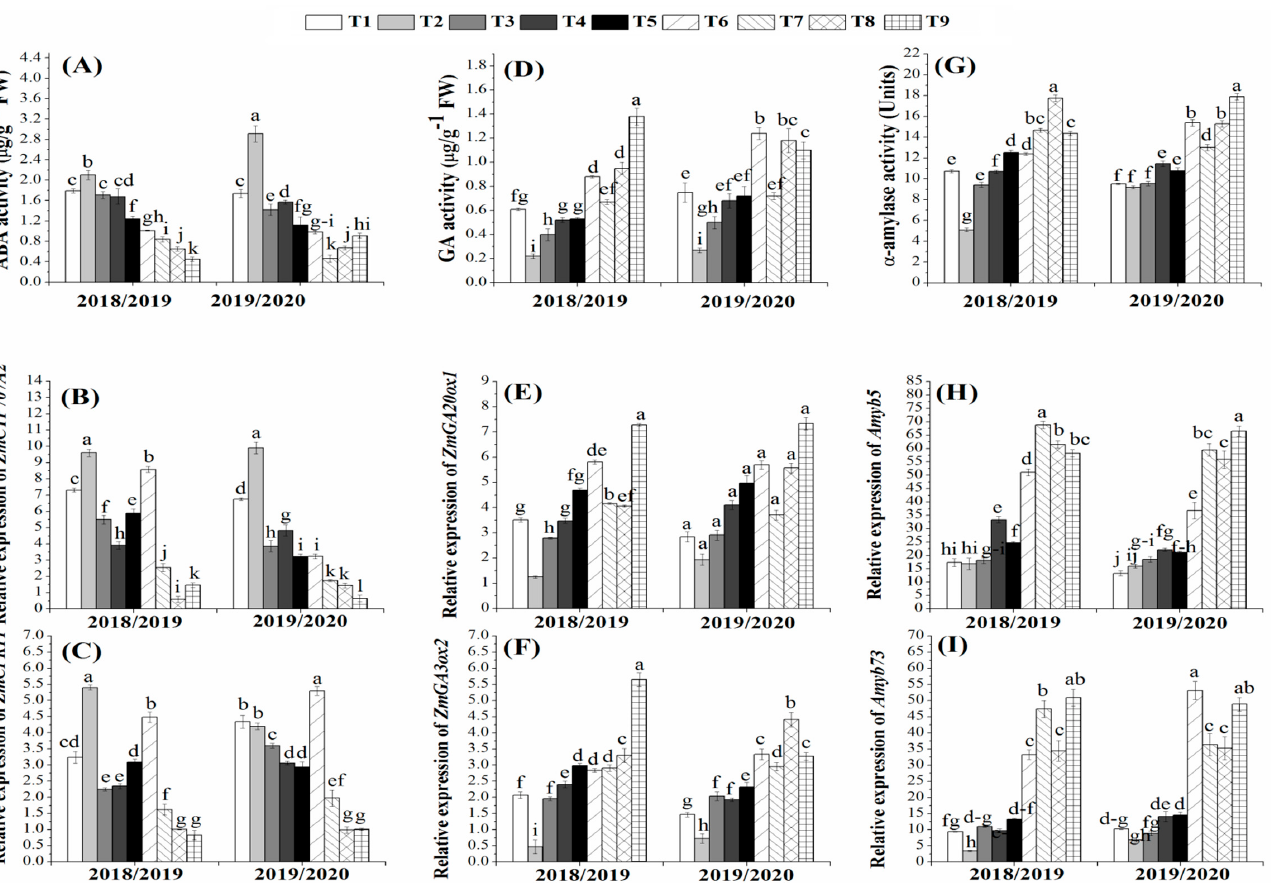
Figure 3. E ff ects of organic and biofertilizers alone or in combination on ABA activity ( A ) and its transcription levels ( B , C ); GA activity ( D ) and its transcription levels ( E , F ); α -amylase activity ( G ) and its transcription levels ( H , I ) in maize grains. (T1 = 100% NPK, T2 = 50% NPK, T3 = Biogas slurry + 50% NPK, T4 = Humic acid + 50% NPK, T5 = Biogas slurry + Humic acid + 50% NPK, T6 = Biofertilizer mixture + 50% NPK, T7 = Biogas slurry + Biofertilizers + 50% NPK, T8 = Humic acid + Biofertilizers + 50% NPK, T9 = Biogas + Humic + Biofertilizers + 50% NPK). Di ff erent letters mean significant di ff erence at p < 0.05.